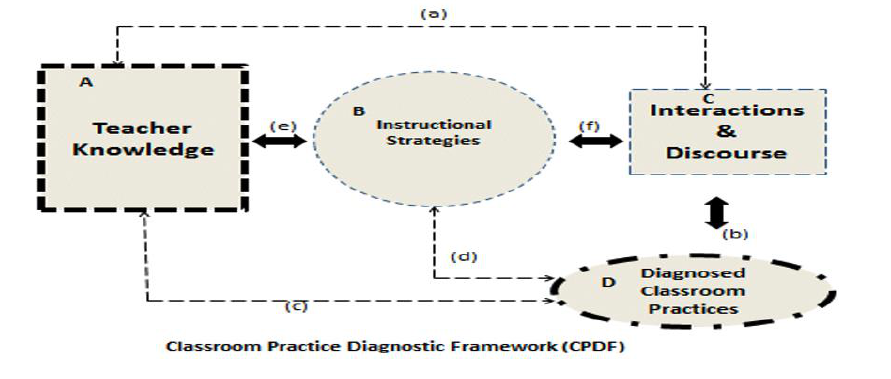
Figure 1 : The Classroom Practice Diagnostic Framework ; Source: Mudau, 2013.